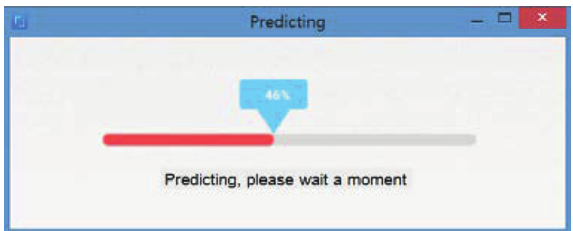
Figure 15: The procedure of prediction.